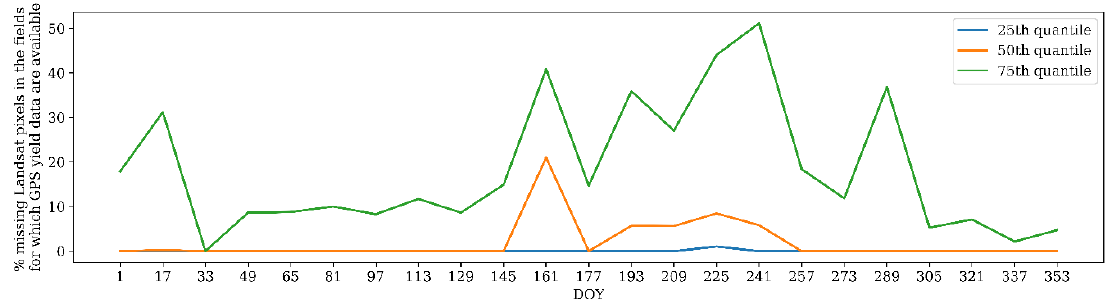
Figure 3. The quantile of Landsat missing pixels in the fields for which observed yield data are available (2009 to 2015).